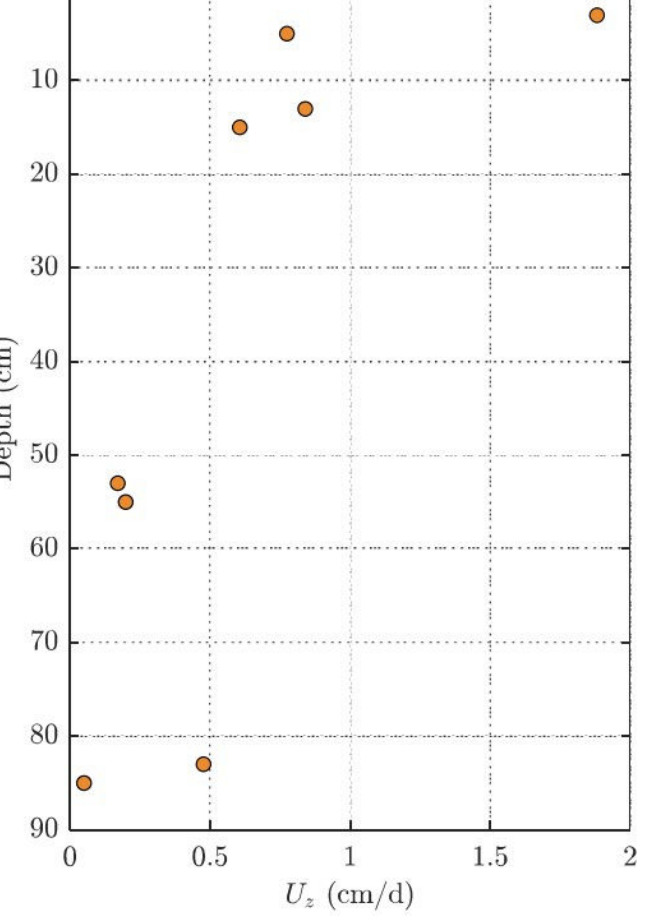
Figure 6. Upwelling velocity ( U z , cm/d) in the vertical direction at sample location 20 (S20) within the NE sampling